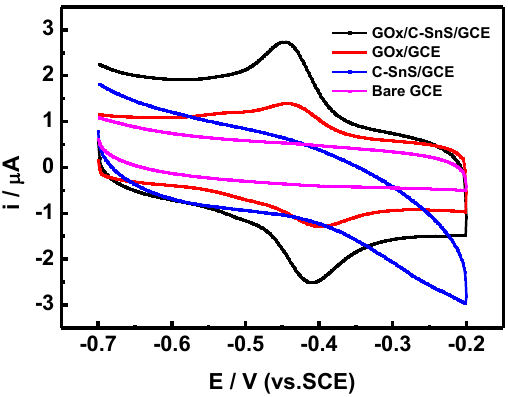
Figure 6. The cyclic voltammetry (CV) profiles of different working electrodes were used to compare with the GO x /SnS/GCE sensor, including bare glassy carbon electrode (GCE), C-SnS coating on GC (C-SnS/GCE), and GO x on GC (GO x /GCE) electrodes. The CV scan was carried out in 0.1 M PBS at a scan rate of 100 mV/s.